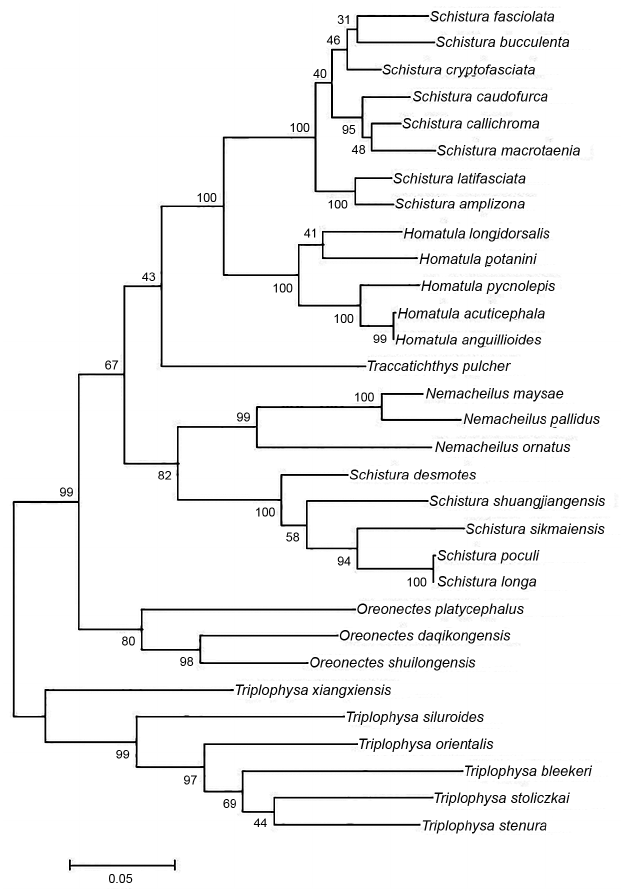
Figure 5. Maximum likelihood phylogenetic trees of